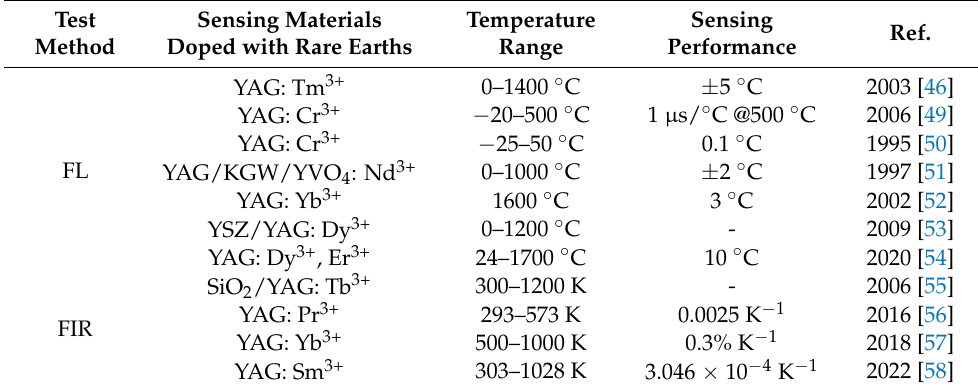
Table 2. Performances comparison of fluorescence-based